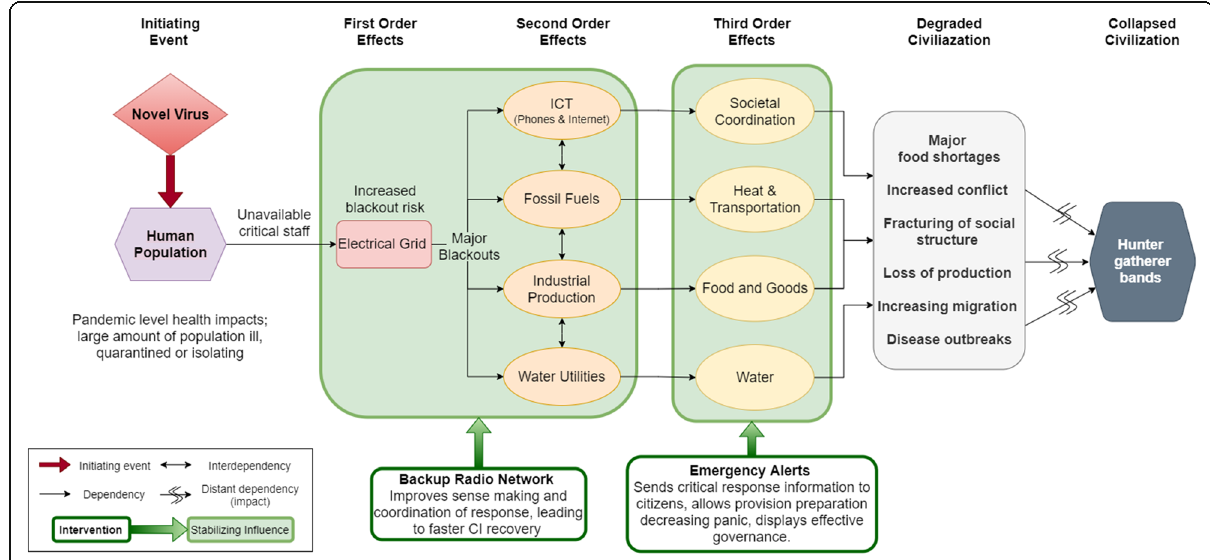
Fig. 1 Causal diagram showing how a novel virus causing a pandemic could cause failure of critical infrastructure leading to loss of industrial civilization. The stabilizing influence of two potential interventions is highlighted in